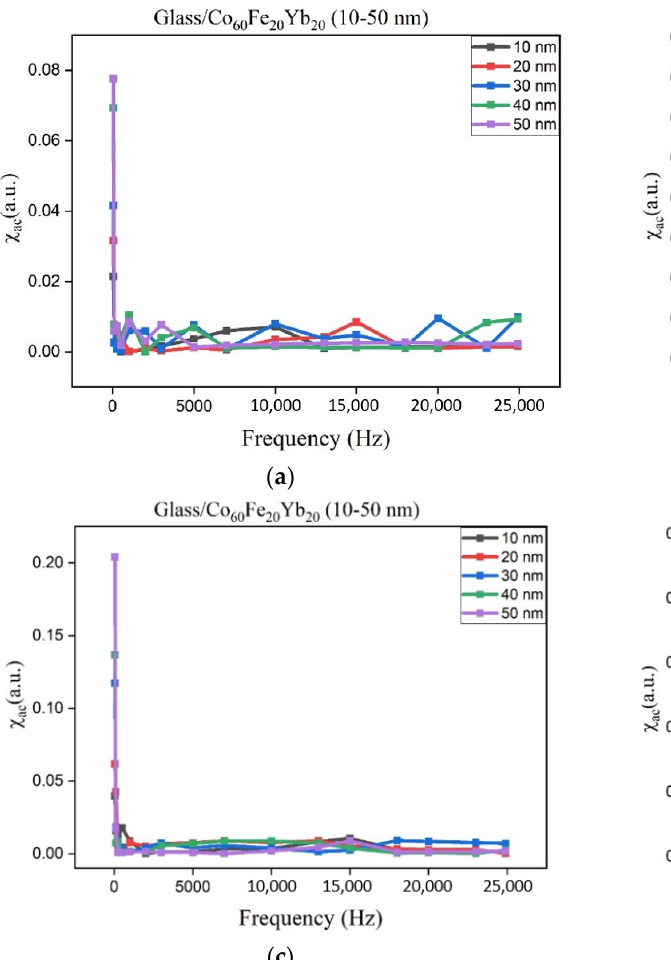
( b ) Figure 4. ( a ) The resistivity of CoFeYb thin films, ( b ) the sheet resistance of CoFeYb films.